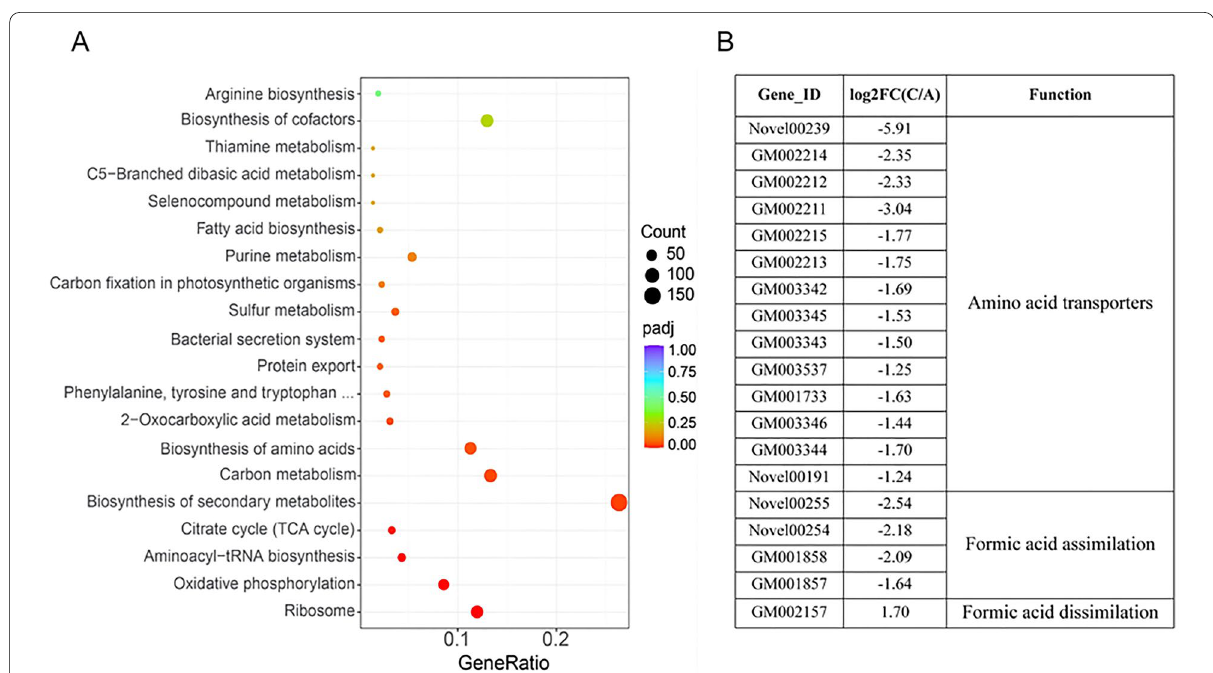
Fig. 5 KEGG pathway enrichment ( A ) and gene information display ( B ) of DEGs in the C vs. A group. The size of the circle represents the number of DEGs in the pathway, and the color of the circle represents padj values (p value adjusted to false discovery rate), reflecting the enrichment